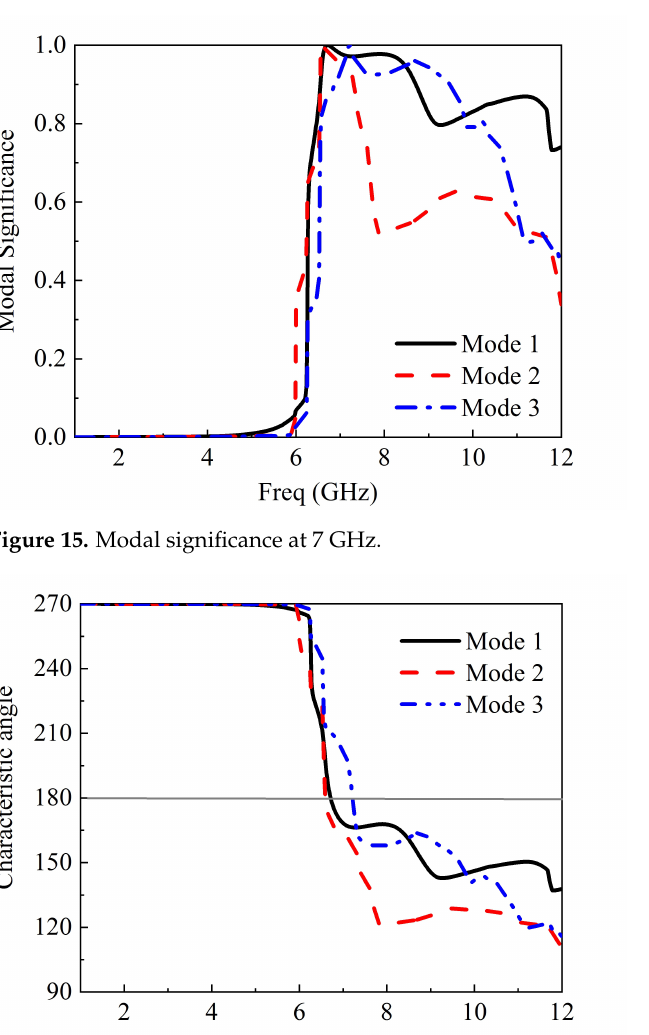
Figure 14. Eigenvalues of three modes at 5.5 GHz.